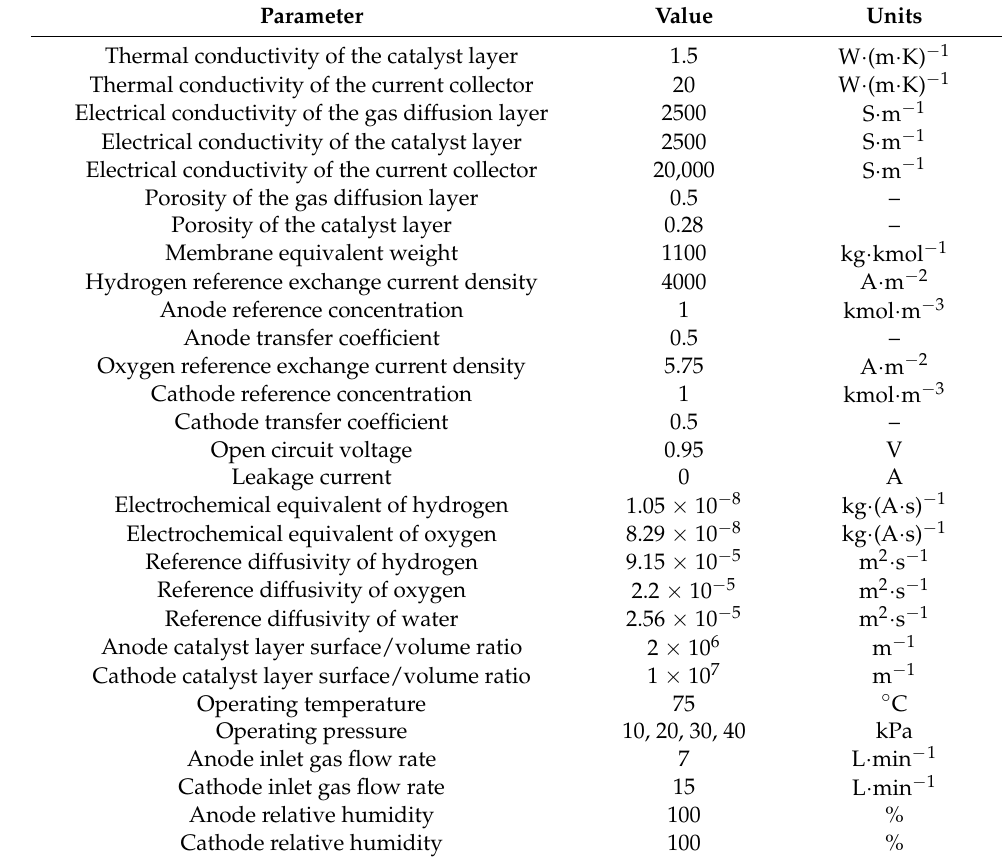
Table 3. Detailed model parameters and operating